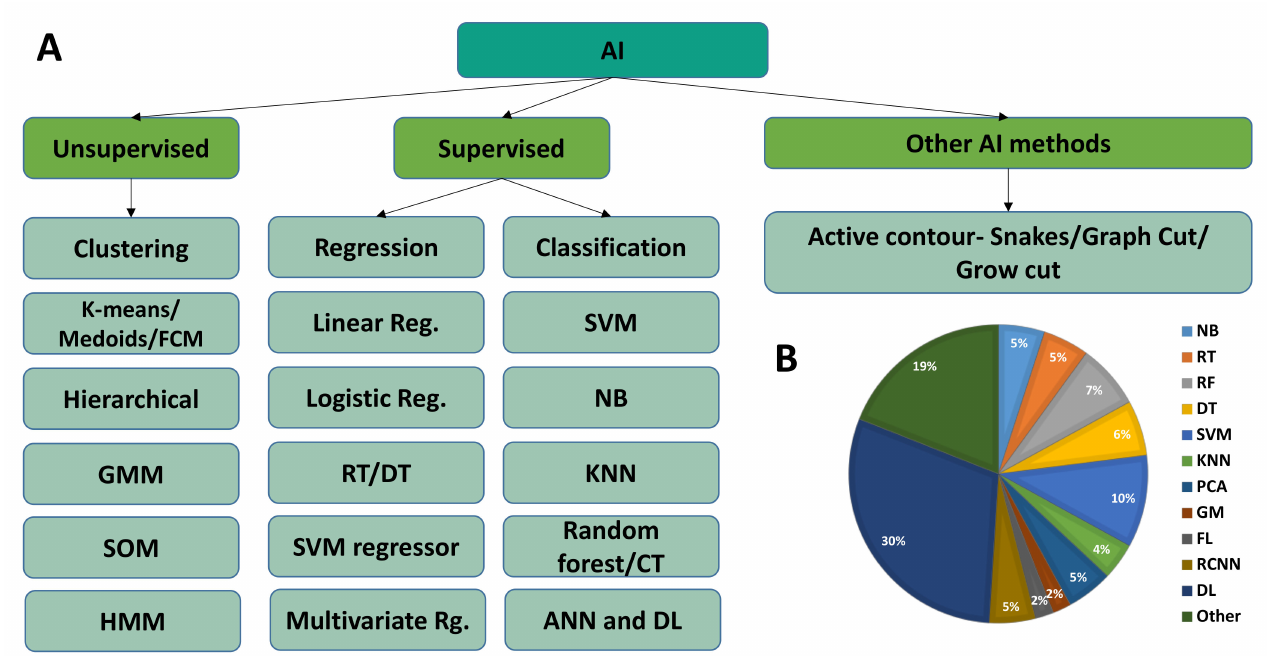
Figure 9. Major AI method used in medical image analysis. ( A ) Method used in image analysis and quantitative medical image data analysis, and ( B ) percentage of each method currently used in medical imaging analysis. Some statistics were also provided by Kumar et al. [1]. The abbreviations used in the figure are as follows: Naive Bayes (NB), support vector machines (SVM), regression tree (RT), random forest (RF), classification tree (CT), classification and regression tree (CART), K-nearest neighbor (KNN), principal component analysis (PCA), hidden Markov model (HMM), Gaussian mixture (GM or GM model), fuzzy logic (FL), regions with CNN (R-CNN), deep learning (DL), self-organized machines (SOM), and artificial neural network